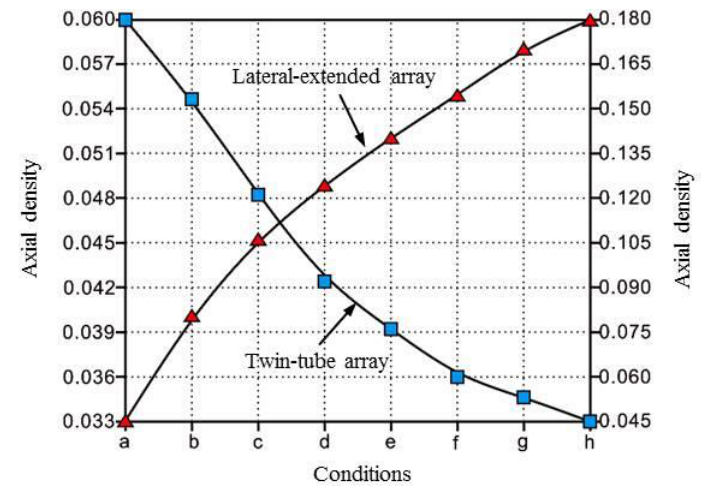
Figure 6. Distribution curve of hyperbolic density along the axial direction of the tunnel. The hyperbolic density along the axial direction of the tunnel improves from 0.033 to 0.060 as the buried depth increases from 3 m to 24 m in the lateral-extended array, and which decreases from 0.180 to 0.045 with the sensor array position of the forward tunnel moving to the rear from 0 m to 70 m in the twin-tube array.